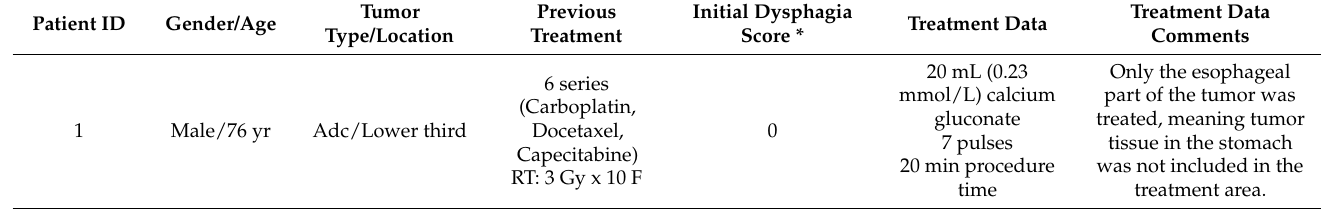
Table 1. Baseline characteristics. Baseline characteristics from all ten patients, including